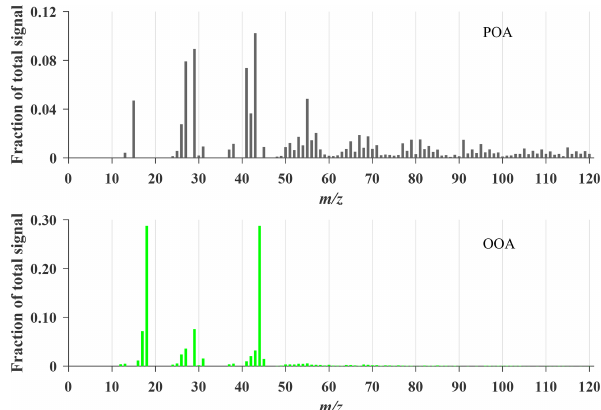
Figure 2. Mass spectra profiles of OA factors for an unconstrained two-factor situation.